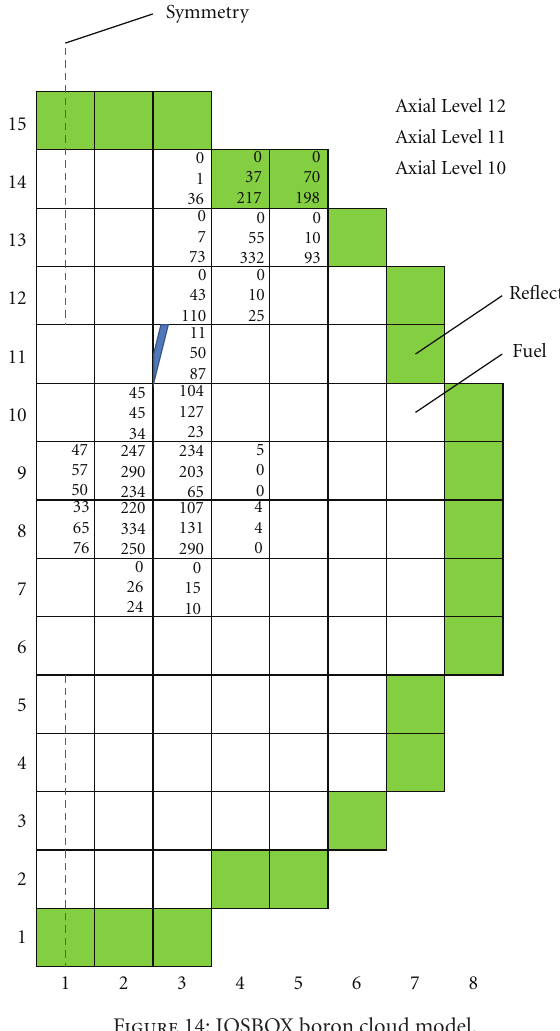
Figure 14: IQSBOX boron cloud model.